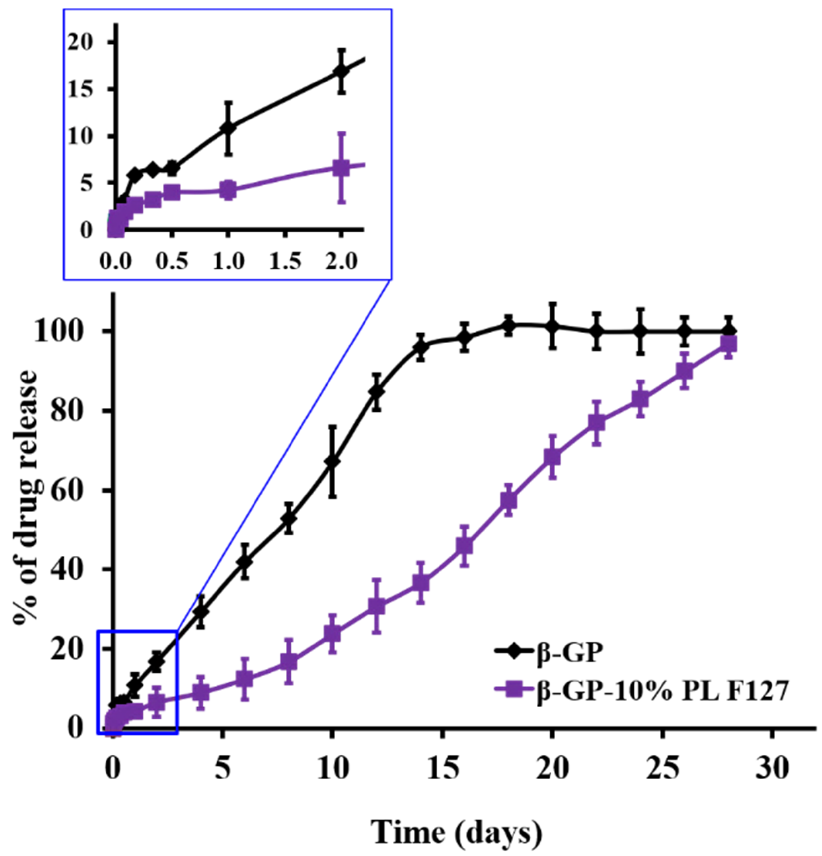
Figure 2. The in vitro release profiles of 5-FU 1% ( w / v ) form either hydrogel system A (chitosan/ β - GP) or hydrogel system B (chitosan/ β -GP + PL) at 37 °C. The results are the mean of three independ- ent experiments ± SD.